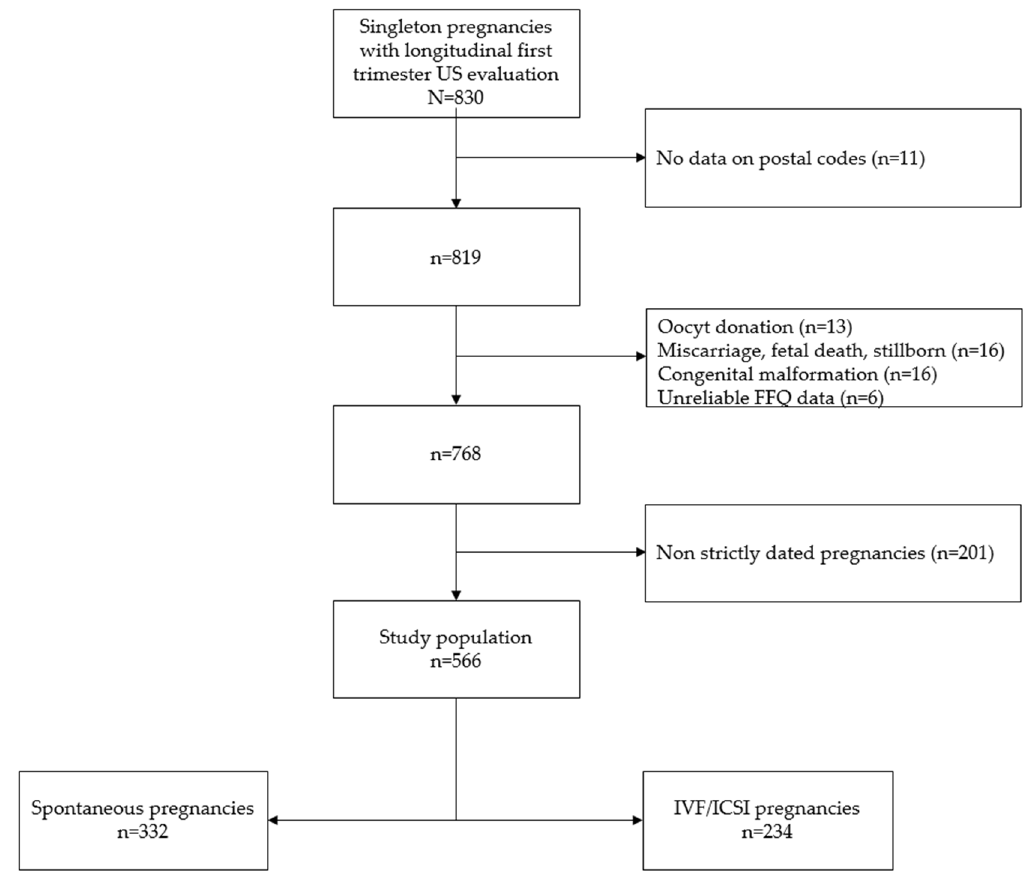
Figure 1. Flowchart of the study population. US: ultrasound, FFQ: food frequency questionnaire, IVF: in vitro fertilization, ICSI: intracytoplasmic sperm injection.